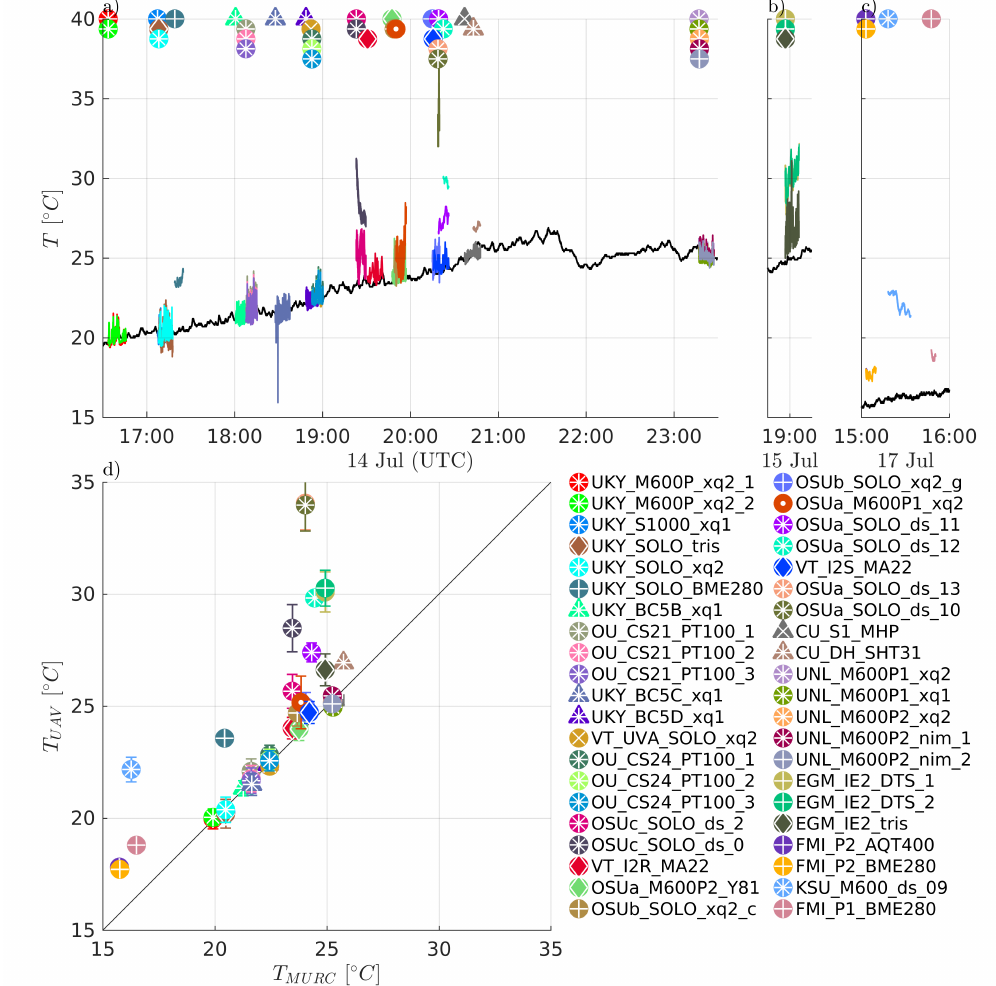
Figure 4. Time series of temperature measurements during July 14 ( a ), 15 ( b ), and 17 ( c ). The black solid line shows the reference observations from the MURC at 18 m AGL, whereas the colored solid lines represent the small unmanned aircraft system (sUAS) observations from the comparison period when the sUAS was flying next to the tower at approximately the same height. The colored symbols at the top mark the start time of the comparison period and their shape indicates the type of sUAS: (cid:52) for fixed-wing systems, and a (cid:13) for multirotor systems. The different white markers on top of the colored symbols indicate the different types of T and relative humidity ( RH ) sensor setups: · for no aspiration and radiation shielding; × for aspiration only; + for radiation shielding only; ∗ for aspiration and radiation shielding; (cid:5) for sensors not impacted by aspiration or solar radiation shielding. The mean differences between the sUAS and the MURC reference observations are shown in ( d ) with error bars indicating standard